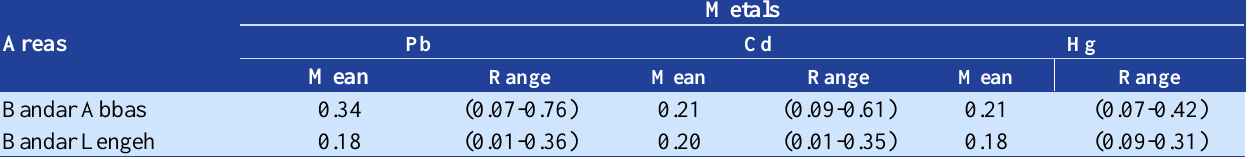
Table 5. Concentrations of Pb, Cd, and Hg in 4 types of fish samples (µg/g dry weight)